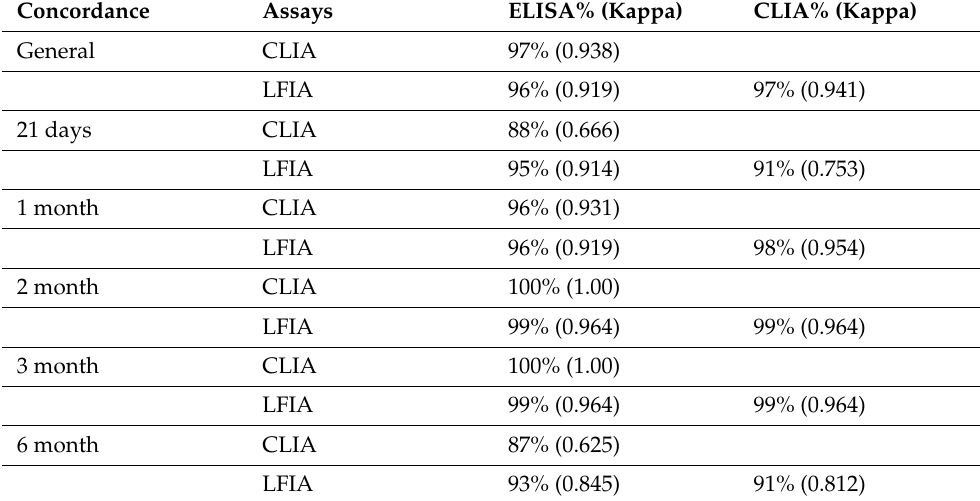
Table 2. The concordance of IgG serologic